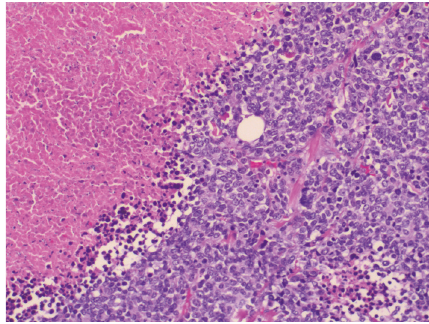
Figure 11: Immunohistochemistry shows positive nuclear staining of the tumor cells for myo-D1 (X200).